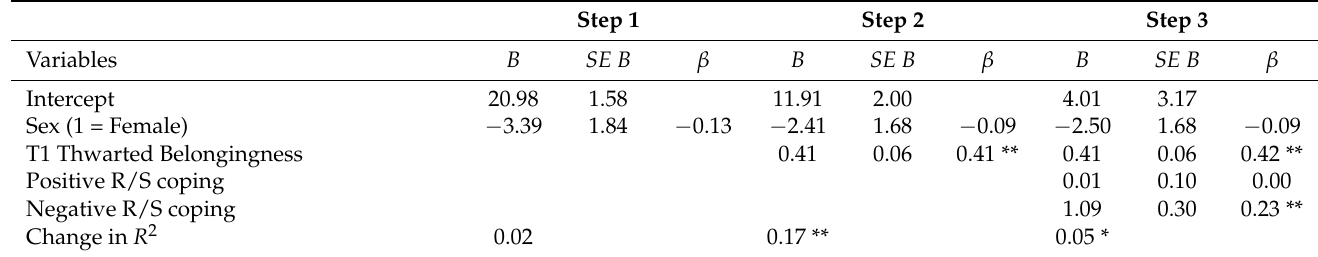
Table 3. Summary of hierarchical regression analysis for T2 Thwarted